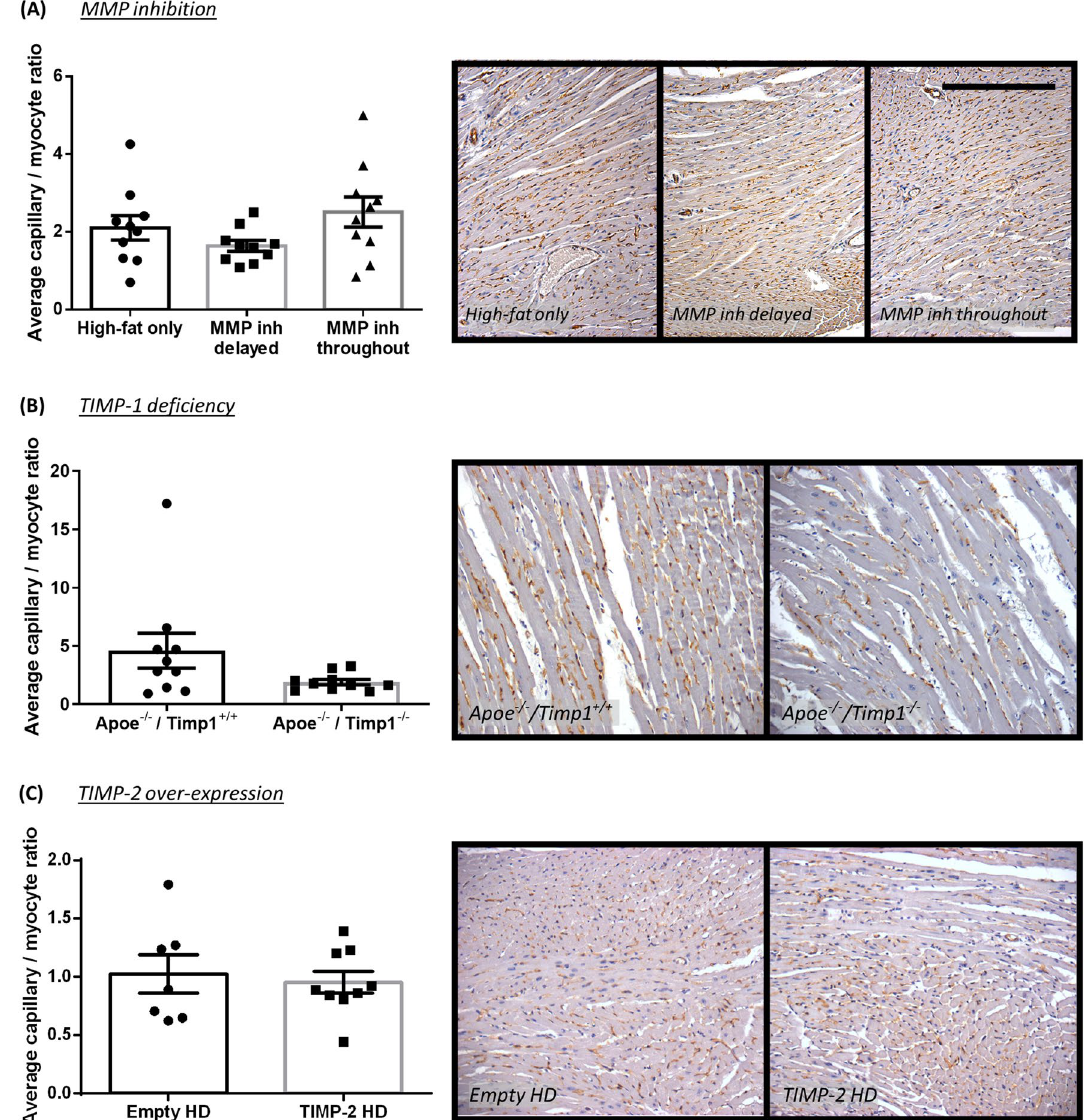
Figure 8. Effect of MMP inhibition and TIMP modulation on capillary to myocyte ratio in atherosclerotic apolipoprotein E-deficient (Apoe -/- ) mice. Quantification and representative images of capillary to myocyte ratio as assessed in isolectin B4-immunohistochemically stained hearts from ( A ) 36-week high-fat fed Apoe -/- mice treated with or without a broad-spectrum MMP inhibitor, ( B ) 36-week high-fat fed Apoe -/- mice deficient for TIMP-1 in comparison to Apoe single knockout controls, and ( C ) 18-week high-fat fed Apoe -/- mice with administration of a TIMP-2 helper-dependent (HD) adenovirus or an empty HD as control. Capillary to myocyte ratio is presented as average/heart cross-section/mouse. Scale bar represents 1 mm and is applicable to all panels. In A and B, n = 10/group; in C, n =